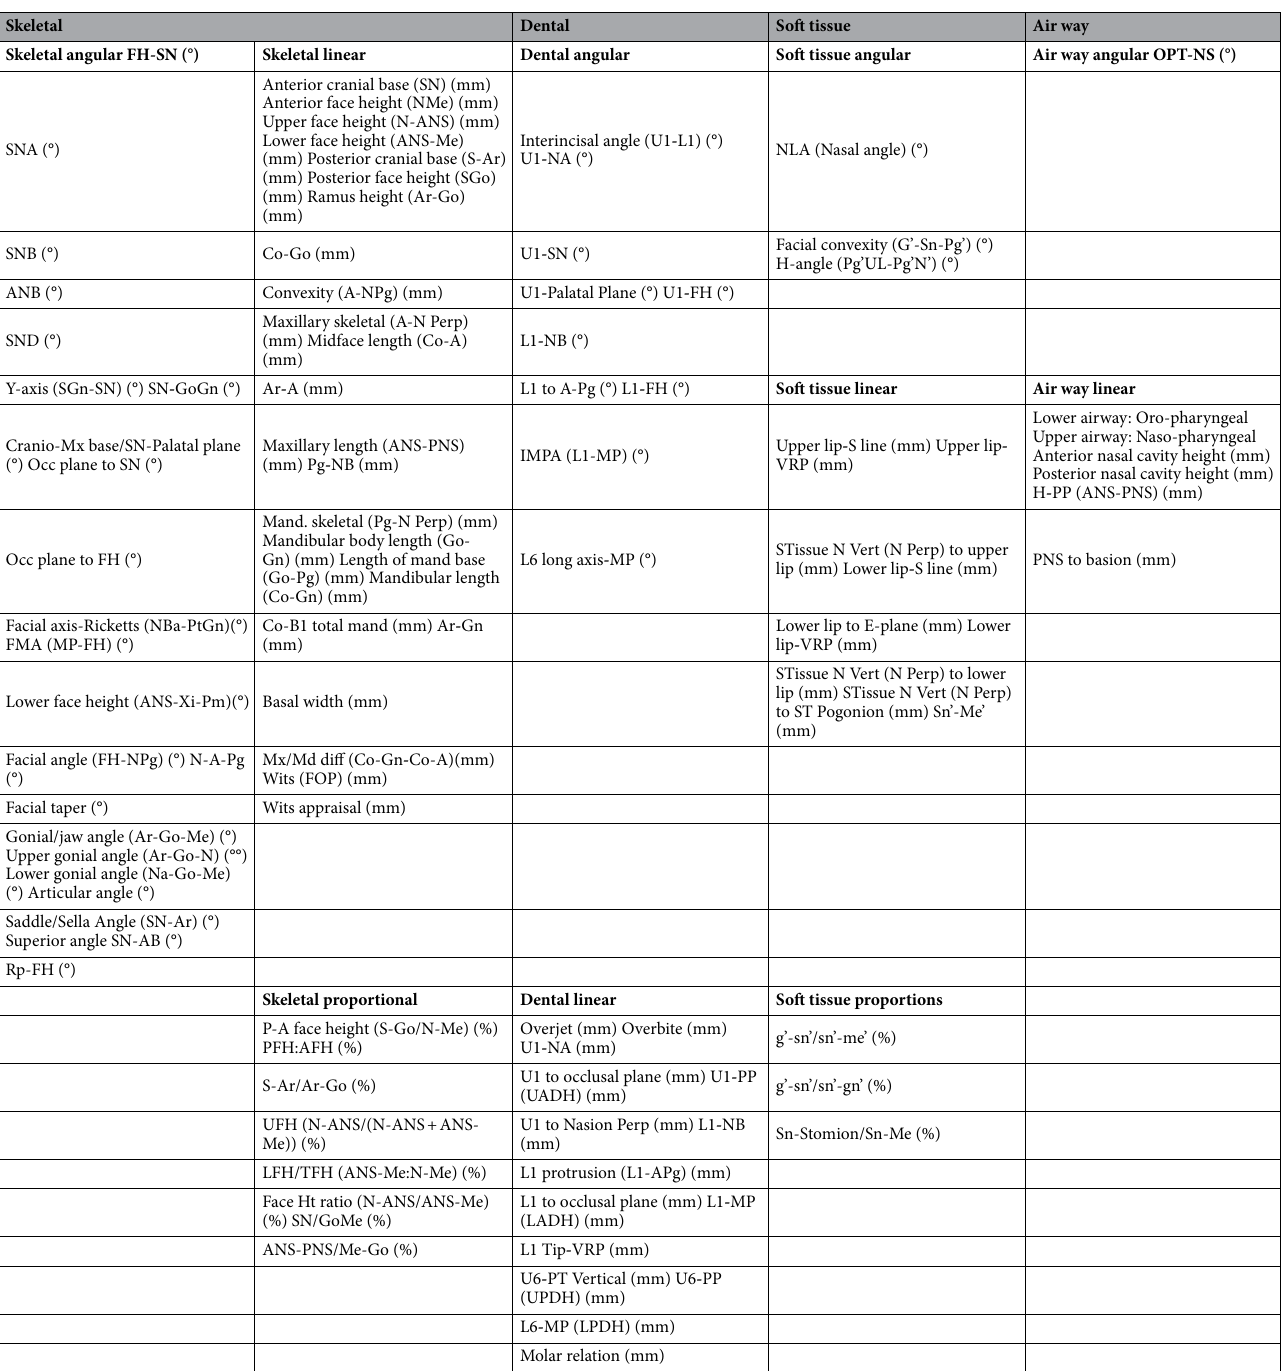
Table 1. Skeletal and supplementary craniometric